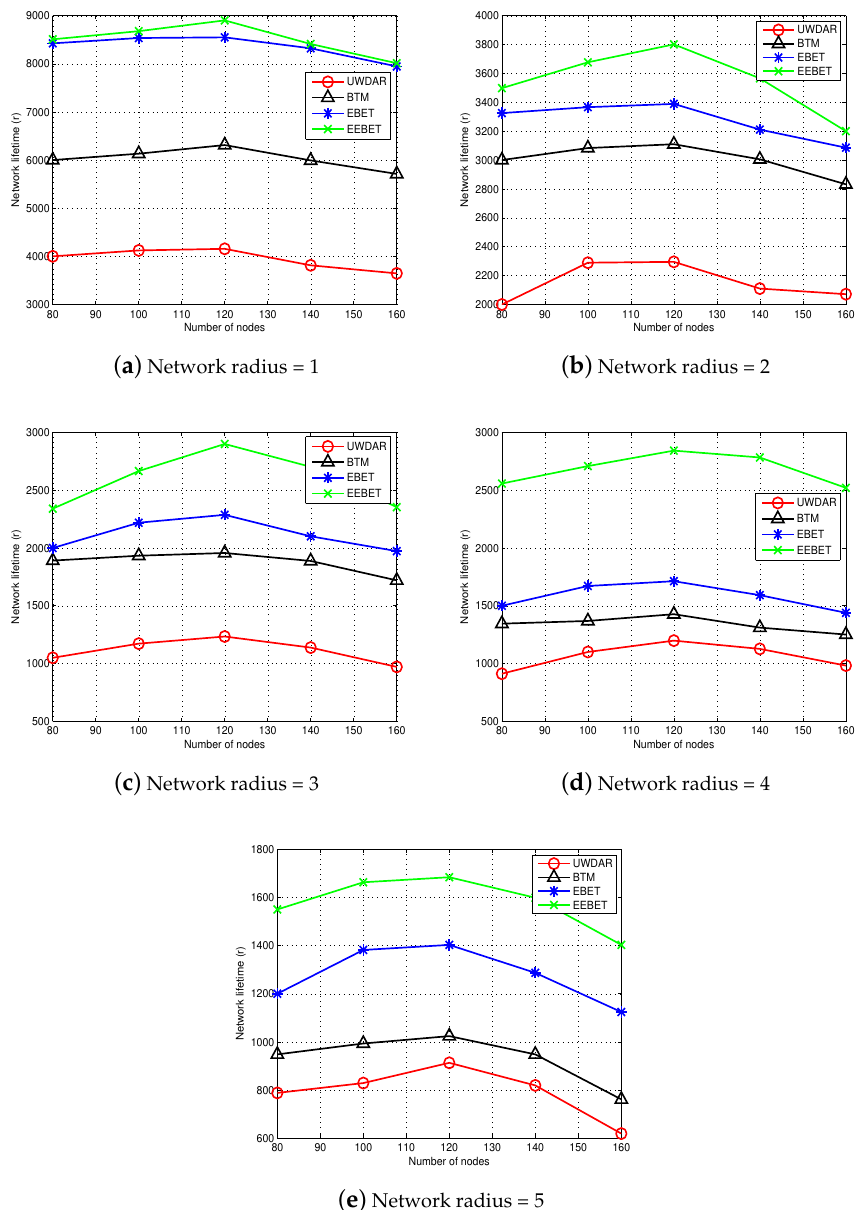
Figure 11. Impact of number of nodes and network radius on network